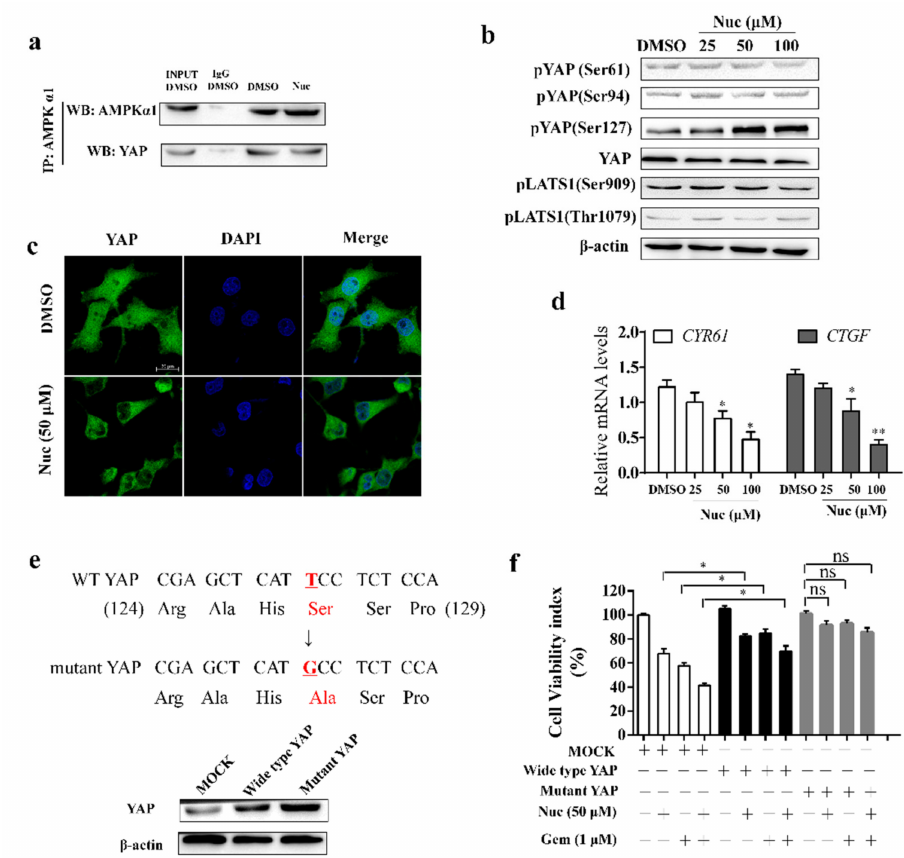
Figure 3. Nuciferine induces YAP Ser127 phosphorylation and inactivation. ( a ) Dimethyl Sulfoxide (DMSO-) or nuciferine -treated cells were lysed and AMPK α 1 was immunoprecipitated. Western blot assays were performed for AMPK α 1 and YAP. ( b ) The whole-cell lysates were prepared and subjected to western blot for pYAP(Ser61), pYAP(Ser94), pYAP(Ser127), YAP, pLATS1(Ser909) and pLATS1(Thr1079). ( c ) YAP nuclear translocation in PANC-1 cells stimulated with nuciferine (50 µ M) for 24 h. Scale bars: 20 µ M. ( d ) Real-time quantitative PCR of CYR61 and CTGF. * p < 0.05 or ** p < 0.01 versus DMSO-treated cells. ( e ) Protein expression of YAP in PANC-1 cells transfected with wild-type YAP or mutant YAP (c.781T → G, encoding p.Ser127Ala). ( f ) Cells transfected with wild-type YAP or mutant YAP overexpressed plasmid were treated with nuciferine and / or gemcitabine for 72 h and cell viability was determined. Data were showed as mean ± SD. Nuc, nuciferine; Gem, gemcitabine; WT, wide type. * p < 0.05 and ns = not